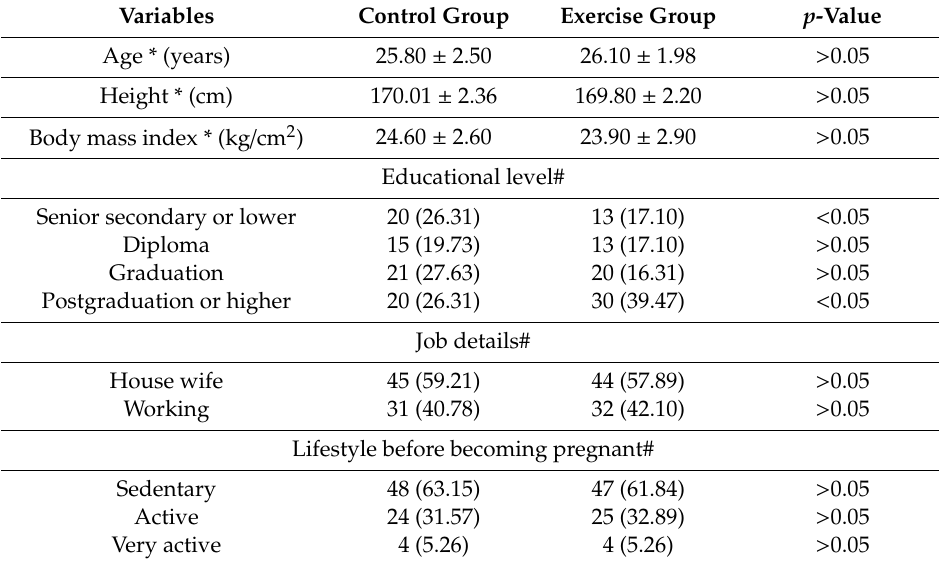
Table 2. Demographic information of the subjects in the control ( n = 76) and experimental ( n = 76) groups).